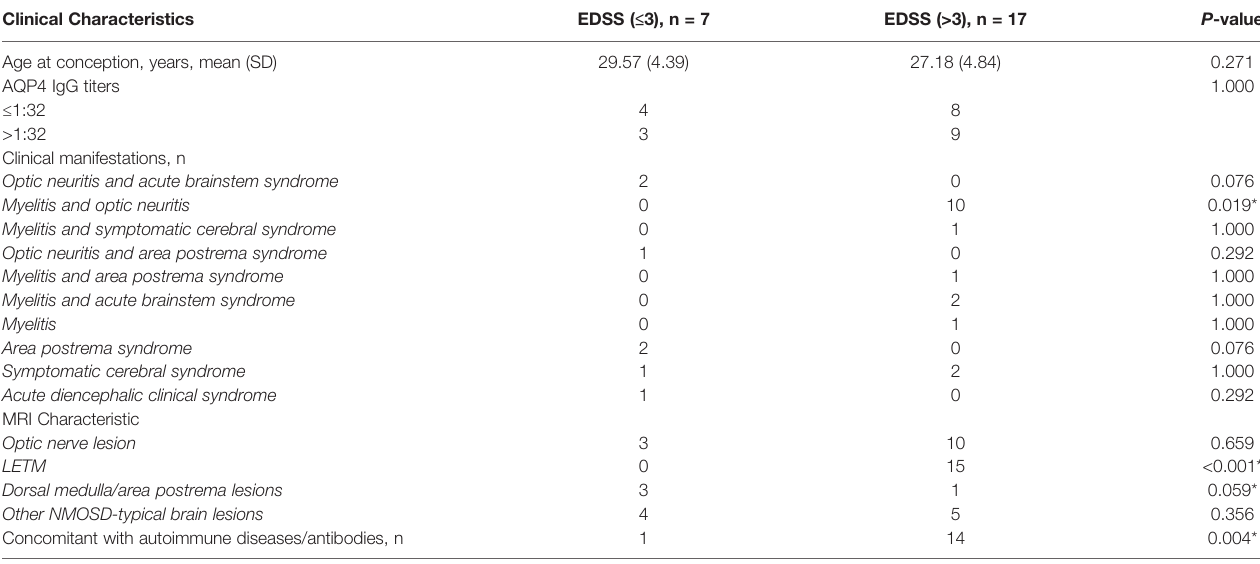
TABLE 2 | Clinical characteristics of patients with pregnancy-related NMOSD attack according to the EDSS score at NMOSD onset or relapse. Clinical